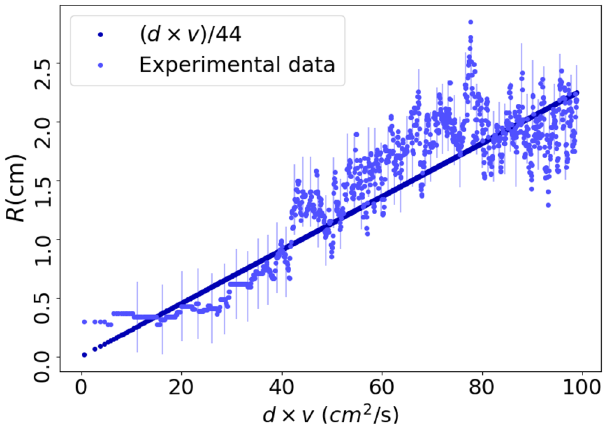
Fig. 4. R as a function of d × v , d is the diameter of the plunging jet, h = 30 cm.